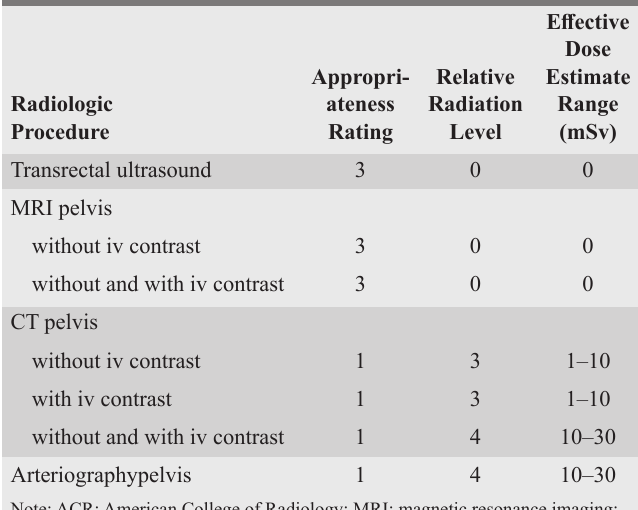
Table 3. ACR Appropriateness Criteria ® on Hematospermia; Patients Under 40 Years of Age with Transient and Monosymptomatic Hematospermia (Modified from Expert Panel on Urologic Imaging, 2017). 24